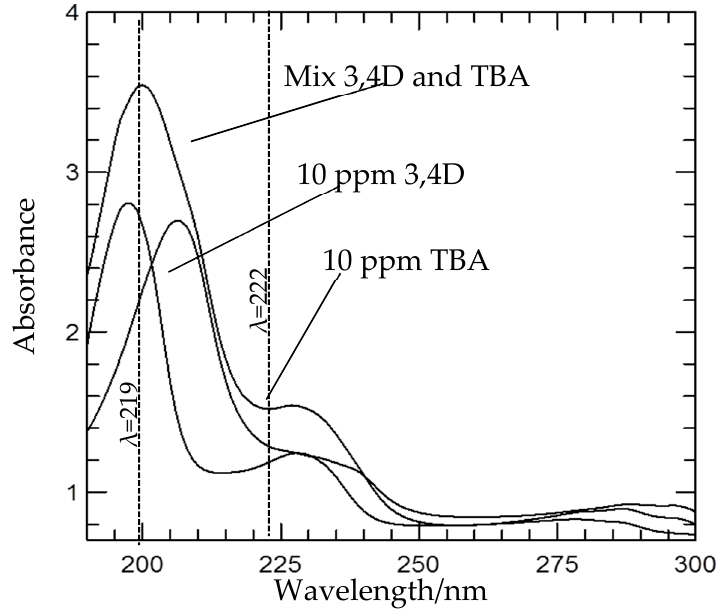
Figure 3. UV-Vis spectra for 3,4D and TBA with λ max at 219 and 222 nm.